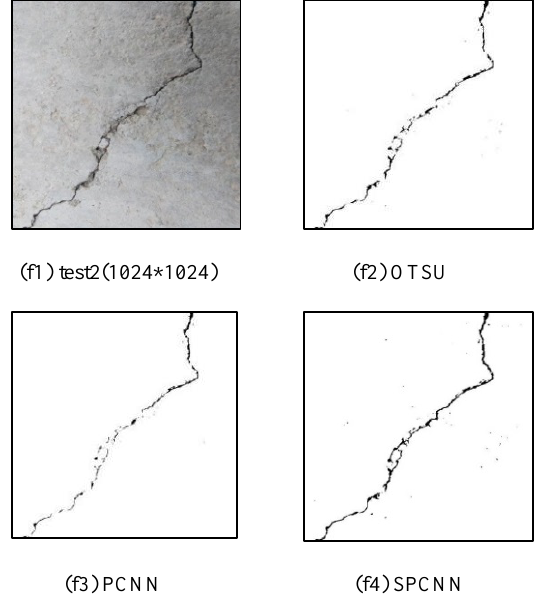
Figure 6. Segmentation results of uneven illumination images by three segmentation methods